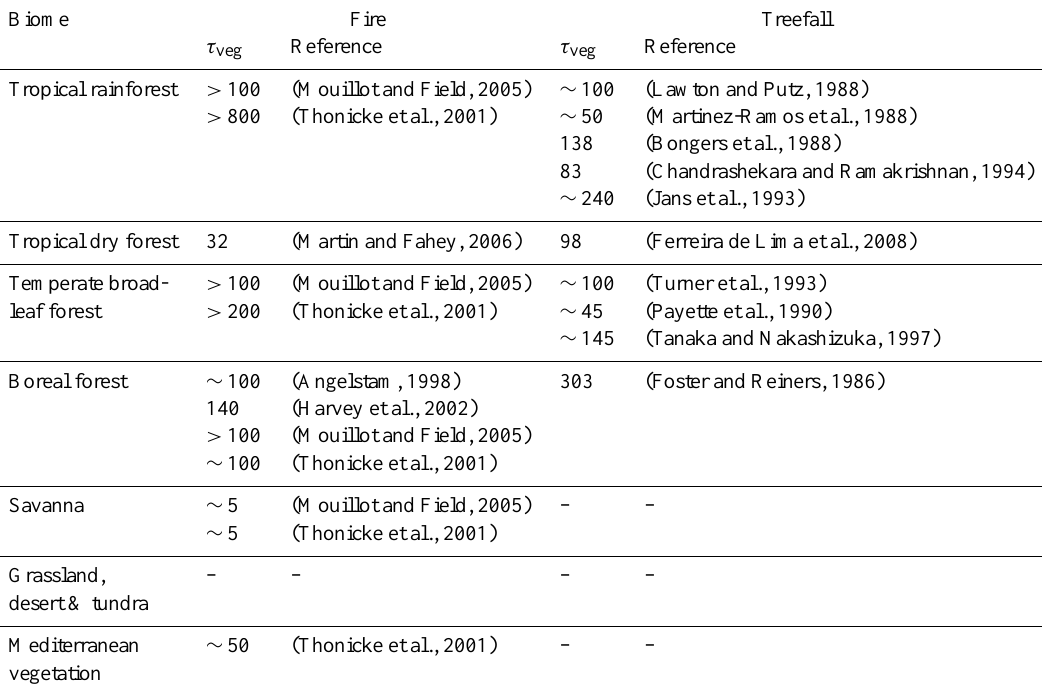
Table B4. References for the disturbance intervals τ veg [years] of different biomes regarding fire and tree fall. A “–” means that the corre- sponding type of disturbance probably does not play a significant role for lichens and bryophytes living in the biome.